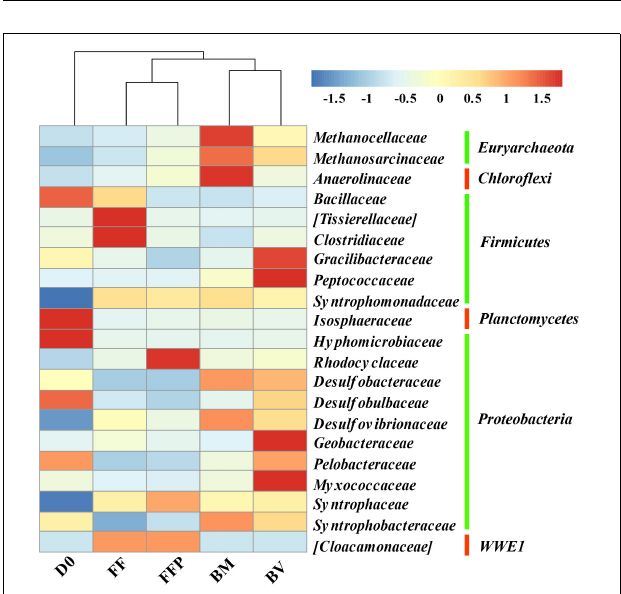
FIGURE 8 | Heat map of the relative abundance of the most abundant operational taxonomic units (OTUs) (the abundance > 1%) from initial soil samples and propionate-fed samples (D0: initial soil sample; FF: ferrihydrite-free cultures; FFP: ferrihydrite-free + P cultures; BM: biogenic-magnetite cultures; and BV: biogenic-vivianite